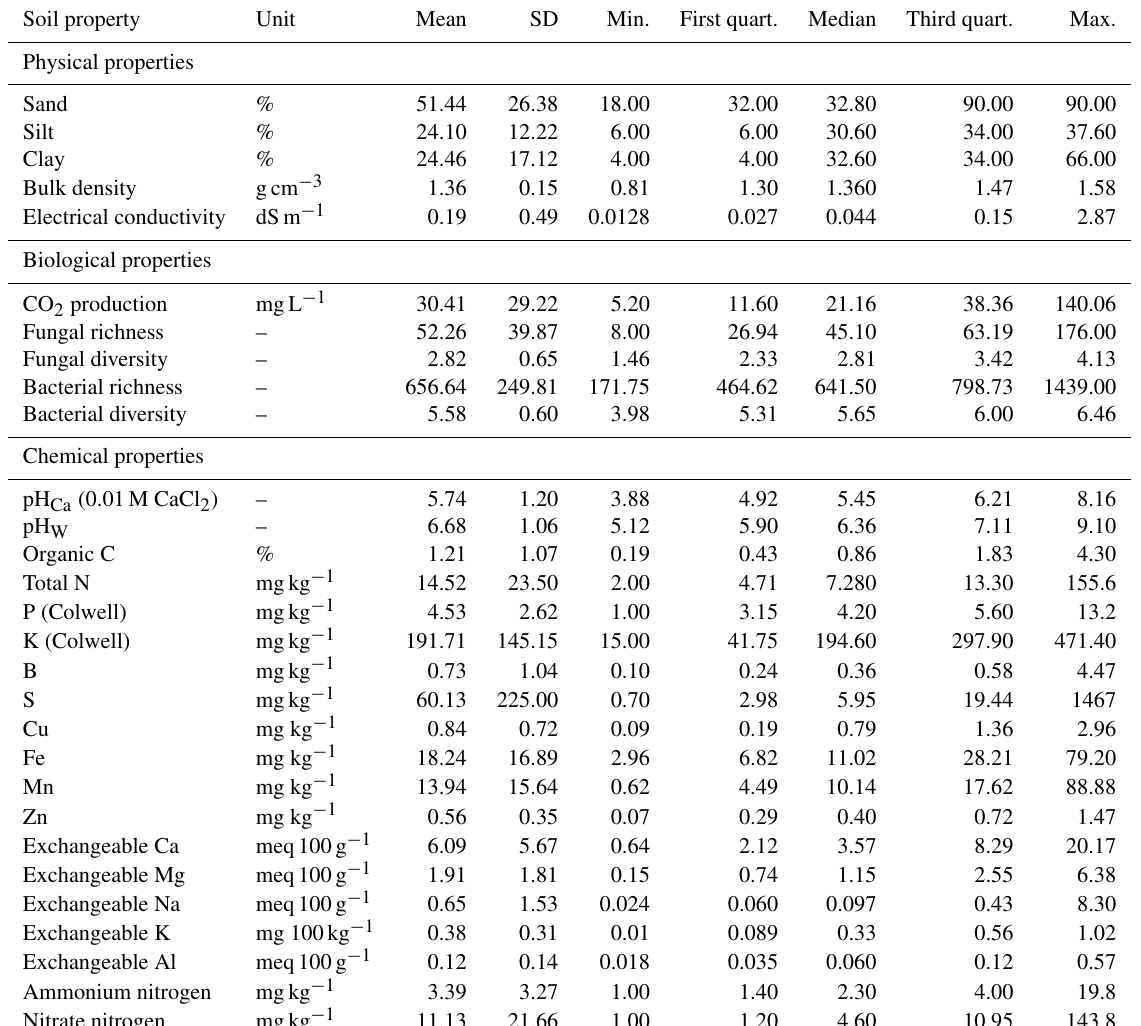
Table 3. Summary of the physical ( n = 5), chemical ( n = 19), and biological ( n = 5) properties (mean, SD, minimum, maximum, median, and first and third quartiles) of reference soil and stockpiled topsoil sampled from seven mine sites in Western Australia, as determined by conventional analytical